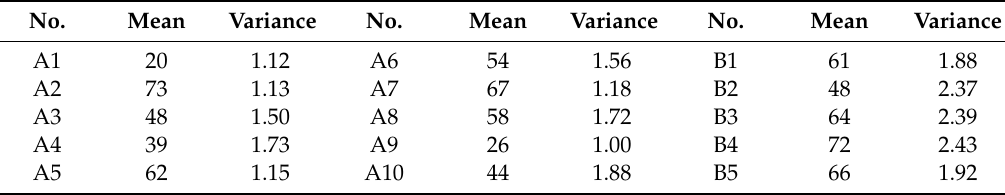
Table 2. Rebound values of A and